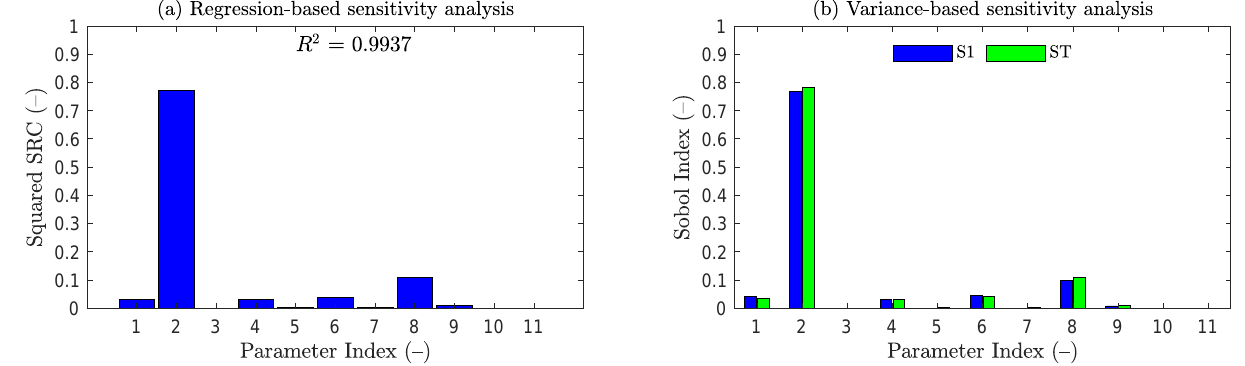
Figure 21. Sensitivity analysis: ( a ) regression-based: SRC; ( b ) variance-based